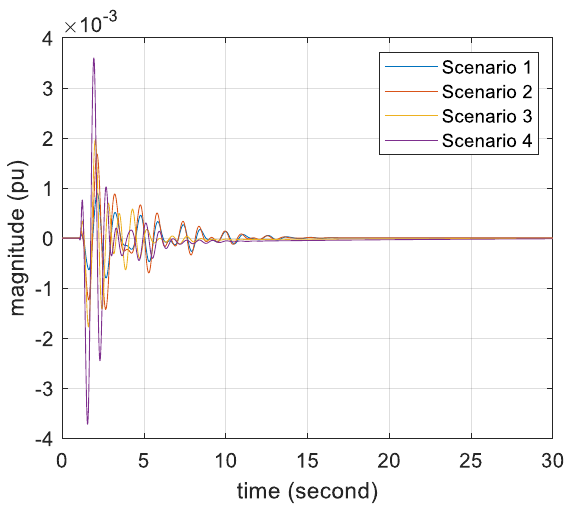
Figure 13. q-axis current response of the PV power system.